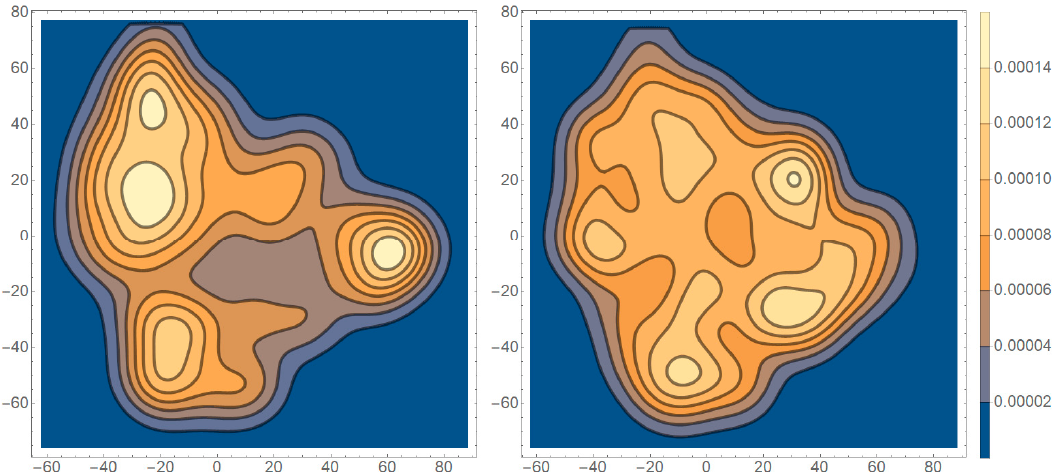
Figure 2. The smooth Gaussian kernel density estimates of the distribution of t-SNE dimension-reduced points obtained for typically developing (TD) ( left ) vs. autism spectrum disorder (ASD) ( right ) subjects (based on data from the right eye).